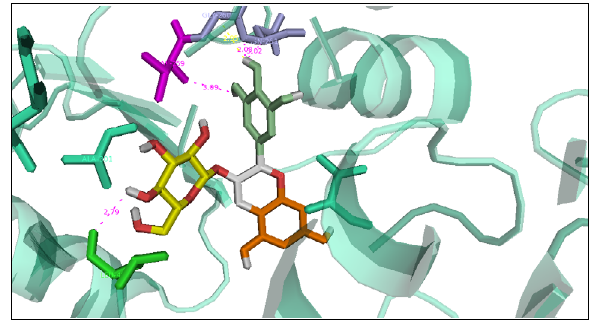
Figure 5: Cy-3-glu docking binding interactions through hydroxyl groups.